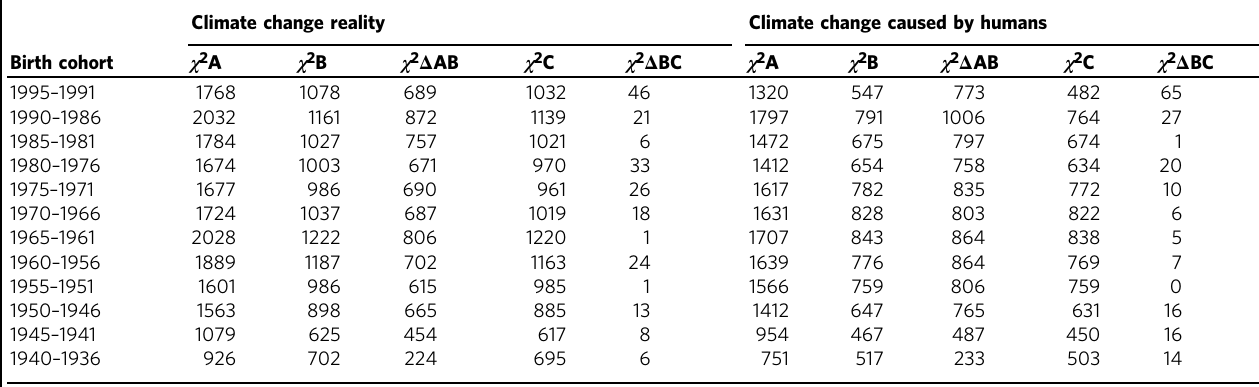
Table 4 Chi-square ( χ 2 ) contributions and differences of each birth cohort for each climate change